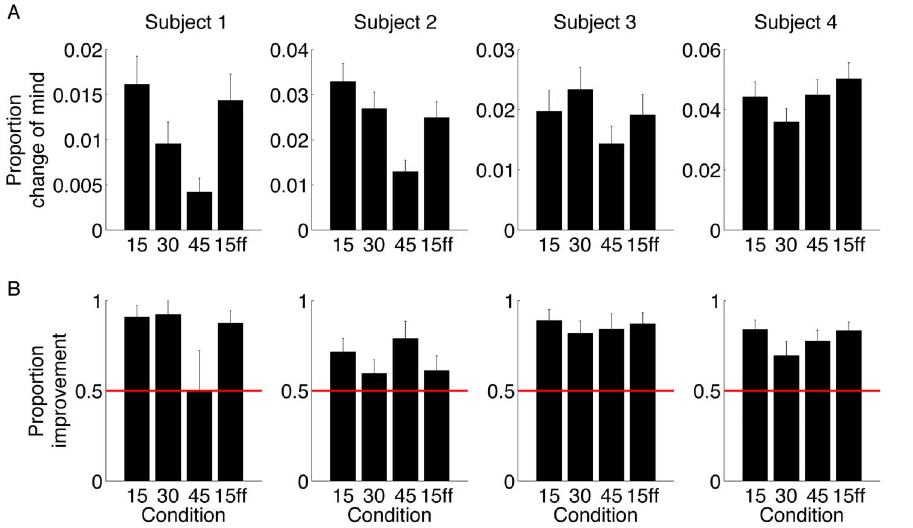
Figure 5. Changes of minds. A. Proportion of trials with a change of mind as a function of the condition for each subject. B: Proportion improvement on change of mind trials - that is the ratio of change of mind trials that correct an error to the total number of change of mind trials. Values exceeding one half (red bar) are consistent with an overall tendency to correct an initial error. Error bars are s.e.